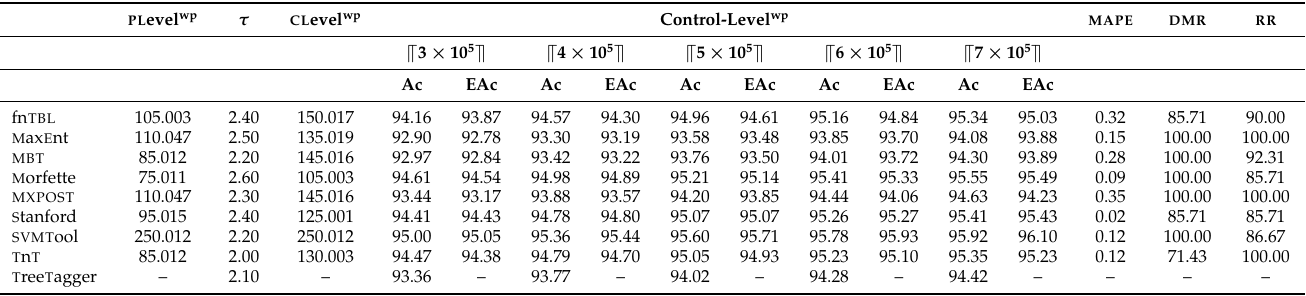
Table 1. Monitoring of runs along the control sequences.